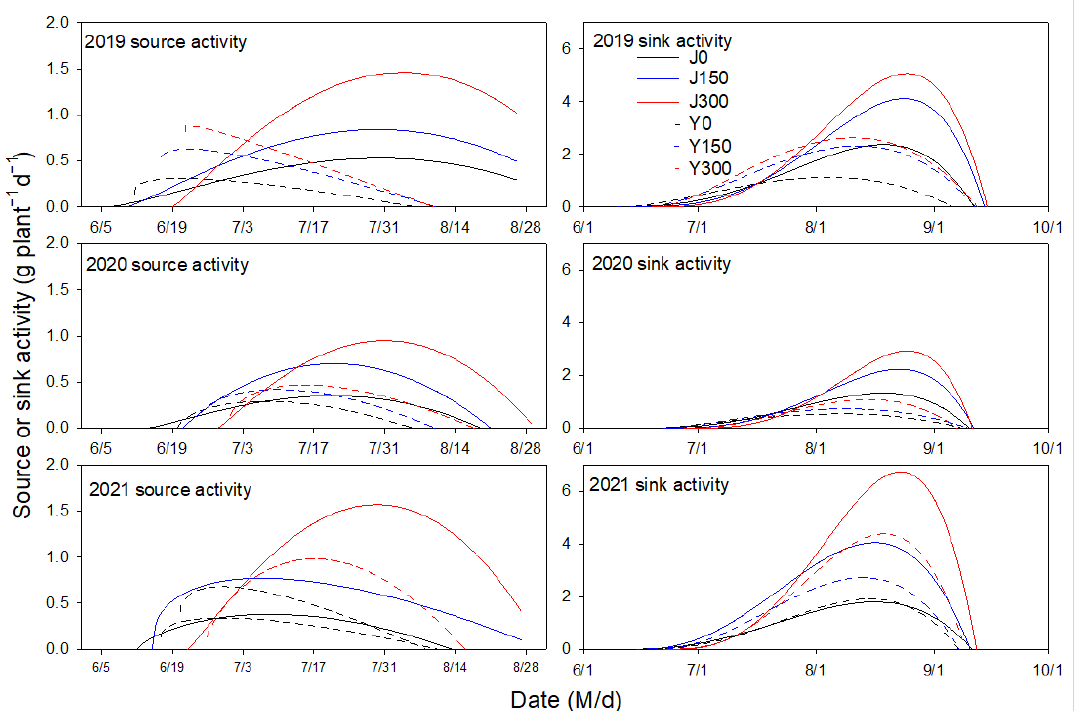
Figure 4. Dynamic changes in source and sink activity of two potato varieties at different nitrogen application rates. The year and the source or sink, are marked in the top left of the figure. The treatments represented by the different line are shown in the